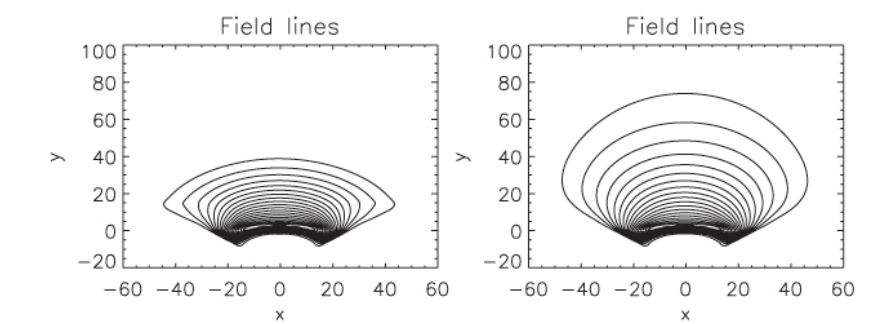
Figure 46: The left and right panels respectively show field line contours from 2.5D flux emergence simulations through the chromosphere excluding and including Cowling resistivity. Image reproduced with permission from Leake and Arber (2006), copyright by